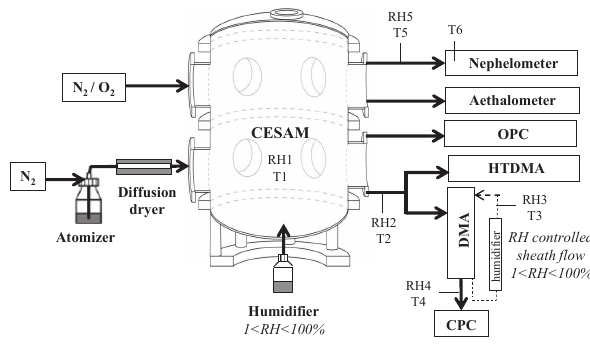
Fig. 1. Experimental set up used to measure aerosol hygroscopic and optical